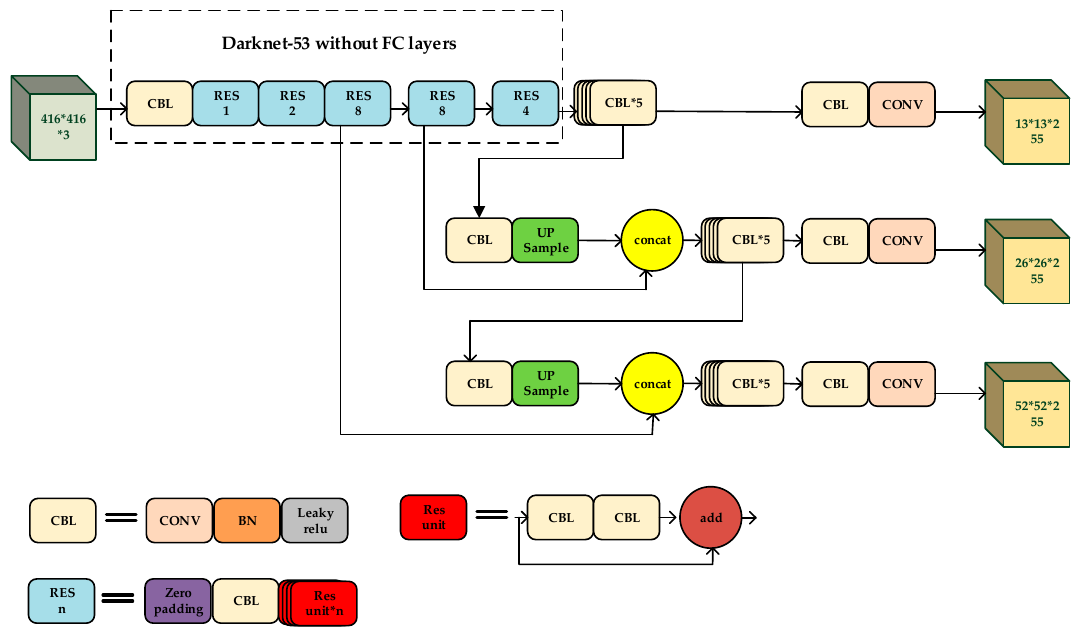
Figure 1. The network of You Only Look Once (YOLO)-V3.